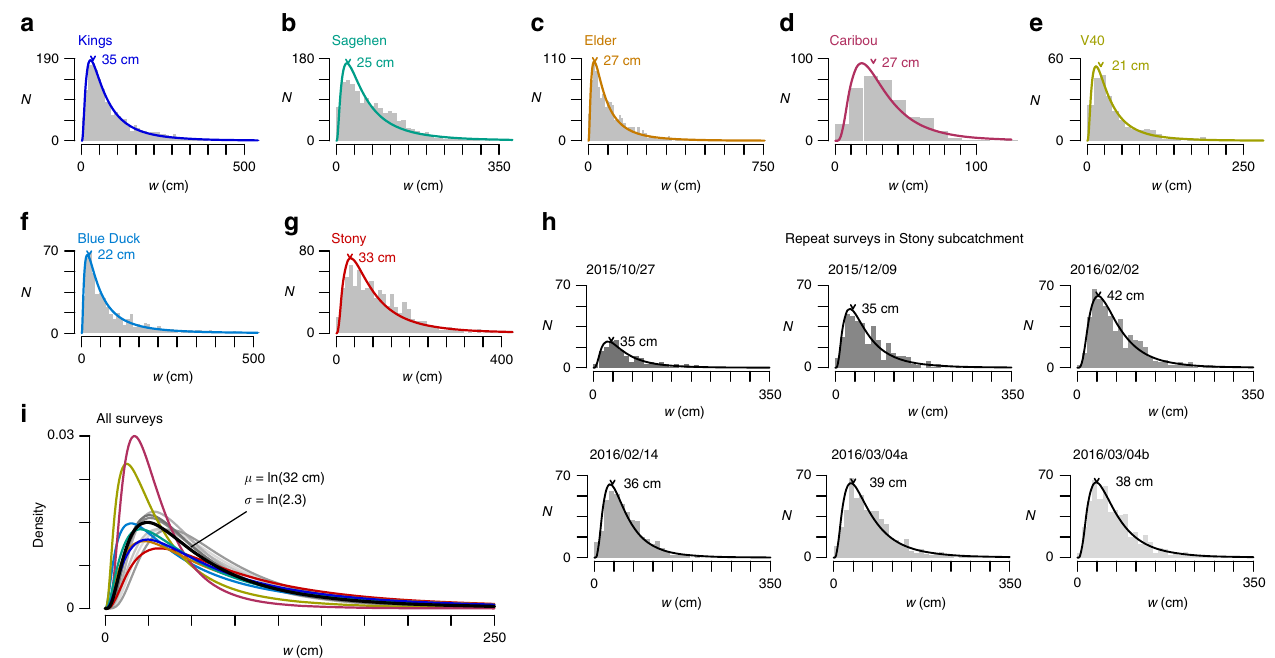
Fig. 3 Headwater stream width distributions. a – h Stream width histograms with lognormal fi ts for each survey. Length values indicate the mode stream width in each catchment. i Composite probability density functions of lognormal fi ts with mean fi t in black. µ and σ are the lognormal location and scale parameters in Eq. (1). N : measurement frequency, w : stream